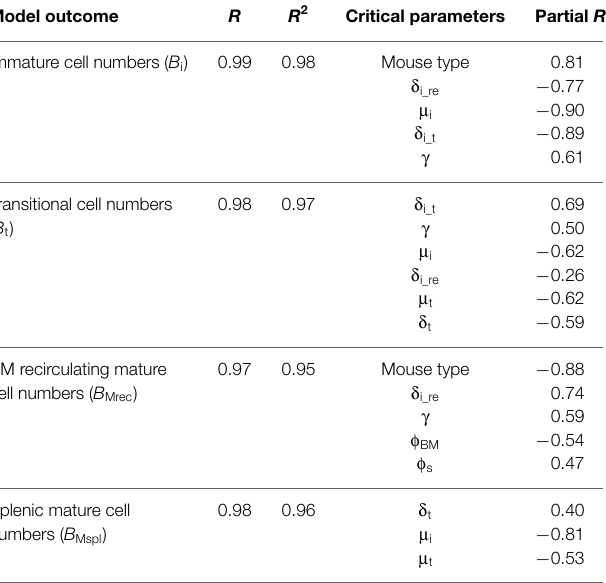
TABLE 2 | Sensitivity analysis by linear regression